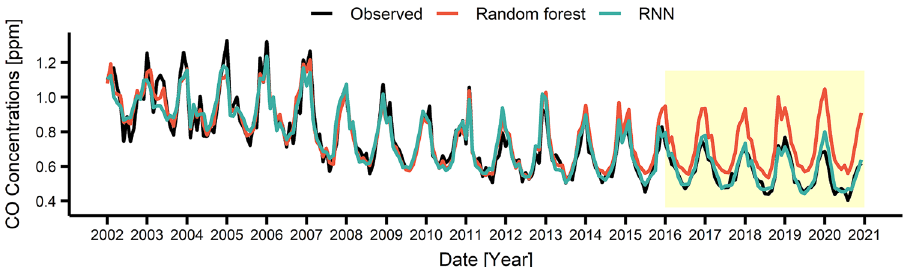
Figure 3. Monthly concentrations of observed and predicted values by using recurrent neural network (RNN) and random forest (RF) for CO. The area shaded in yellow showed the period when the Euro 6 was